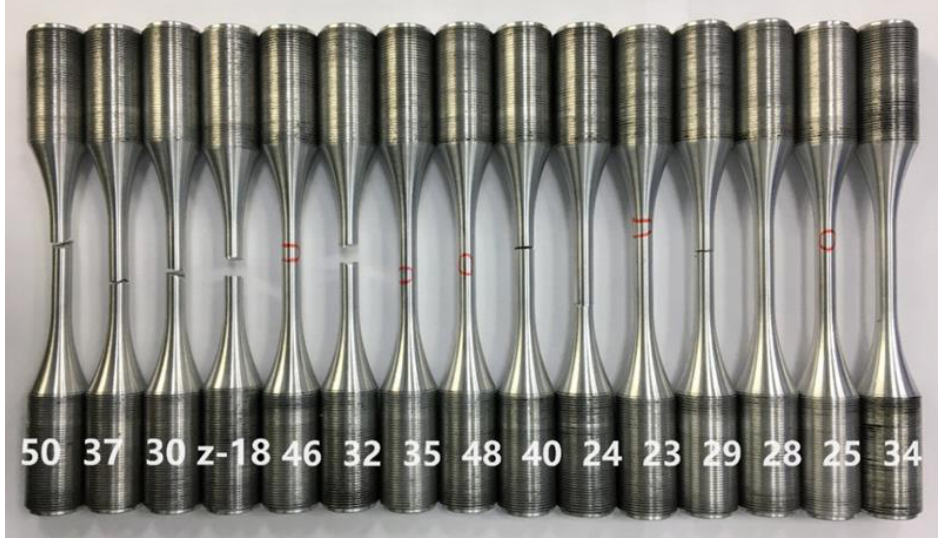
Figure 5. The specimen. Figure 5. The